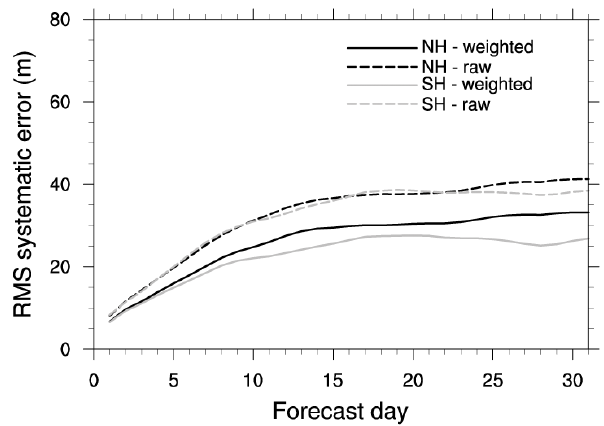
Figure 2. RMS (m) spatially averaged over the Northern (black curves) and Southern (grey curves) Hemisphere extratropics. Dashed lines refer to raw biases (see